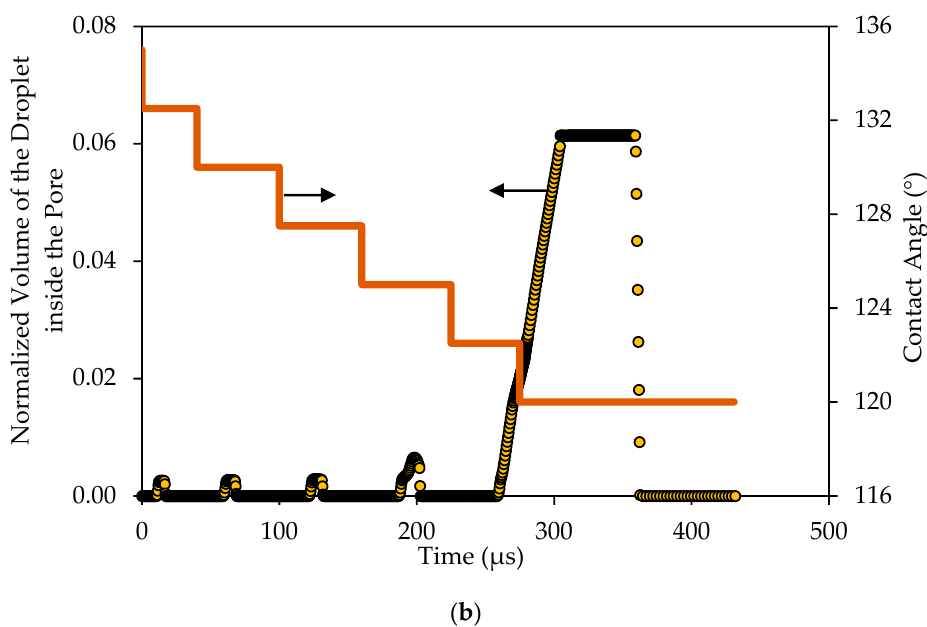
Figure 14. Normalized volume of the droplet (normalized relative to the initial volume of the droplet) in ( a ) the feed channel and ( b ) inside the pore with time for a decreasing contact angle. The operating conditions were as follows: TMP 0.9 bar, top wall velocity 0.9 m/s, and surface tension 0.019 N/m.